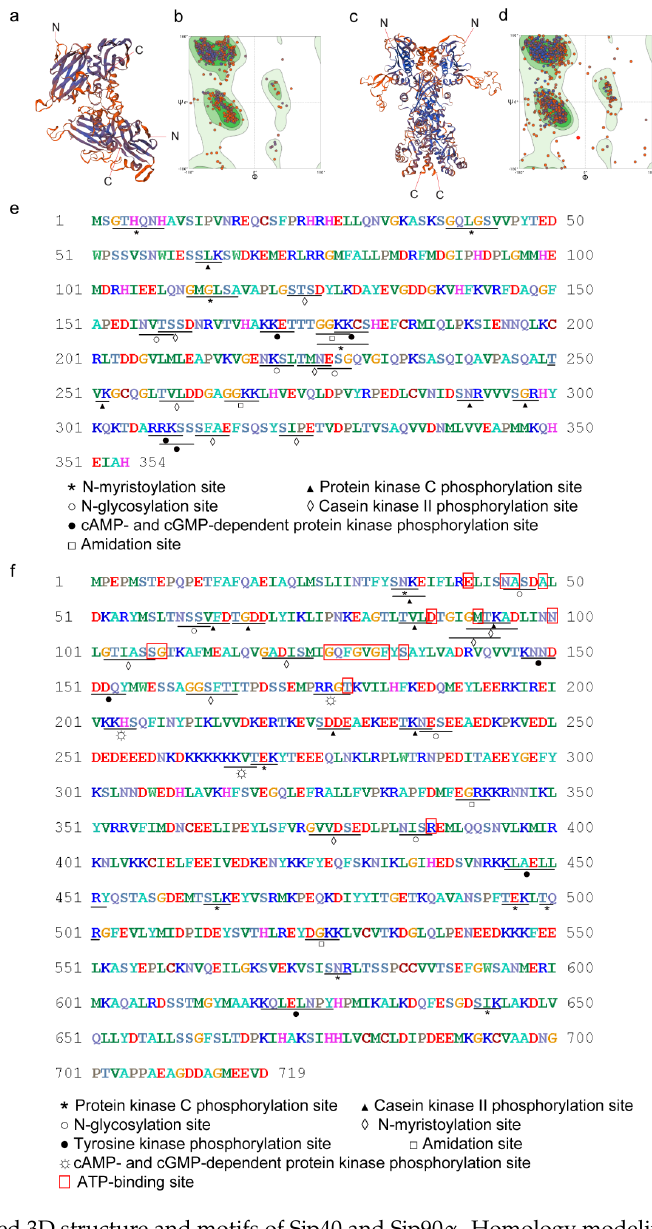
Figure 1. Predicted 3D structure and motifs of Sjp40 and Sjp90α. Homology modeling was performed using the Swiss-Model Server and the predicted 3D structure of homo-dimer Sjp40 ( a ) and homo-dimer Sjp90 ( c ) are shown. Model quality was evaluated using the Ramachandran plot method and the results represent the acceptable stability of the 3D structure of Sjp40 ( b ) and Sjp90 ( d ). ( e ) Sjp40 motifs: